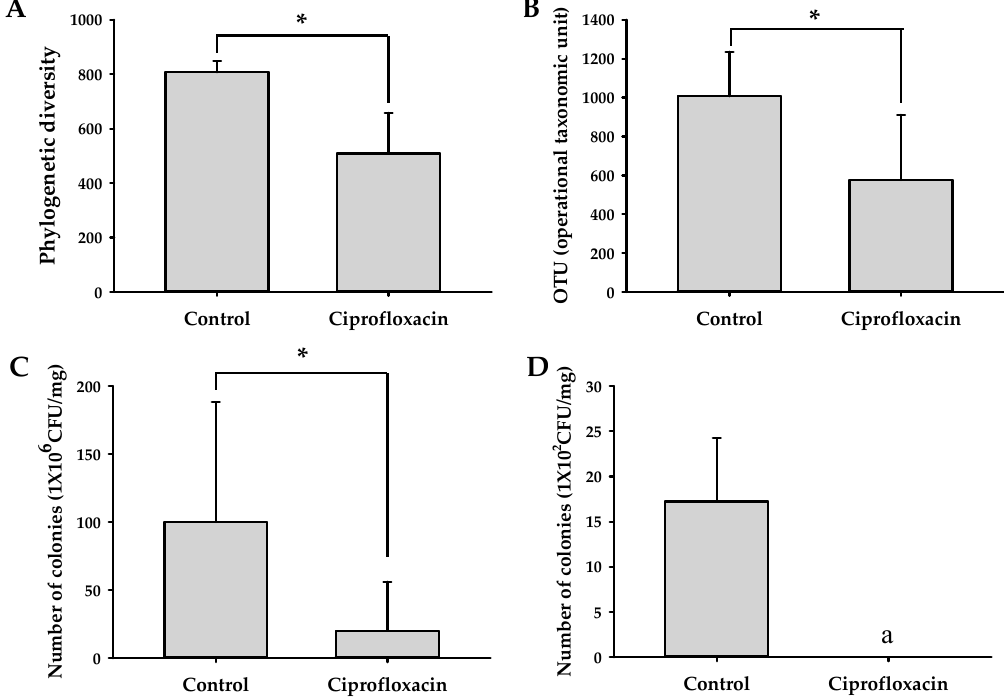
Figure 5. Effect of ciprofloxacin on the growth of the gut microbiota: ( A ) OTUs and ( B ) phylogenic diversity of the fecal microbiome from control and ciprofloxacin-treated mice ( n = 3); the number of colonies grown in ( C ) blood liver (BL) and ( D ) deoxycholate hydrogen sulfide lactose (DHL) agar plates. * p < 0.05 vs. control. a Colony was not observed.